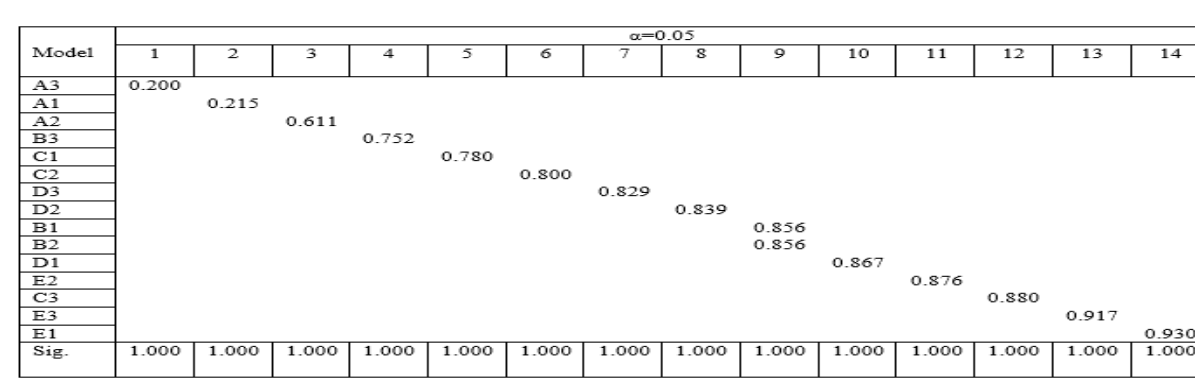
Figure 3. Tukey’s HSD test for